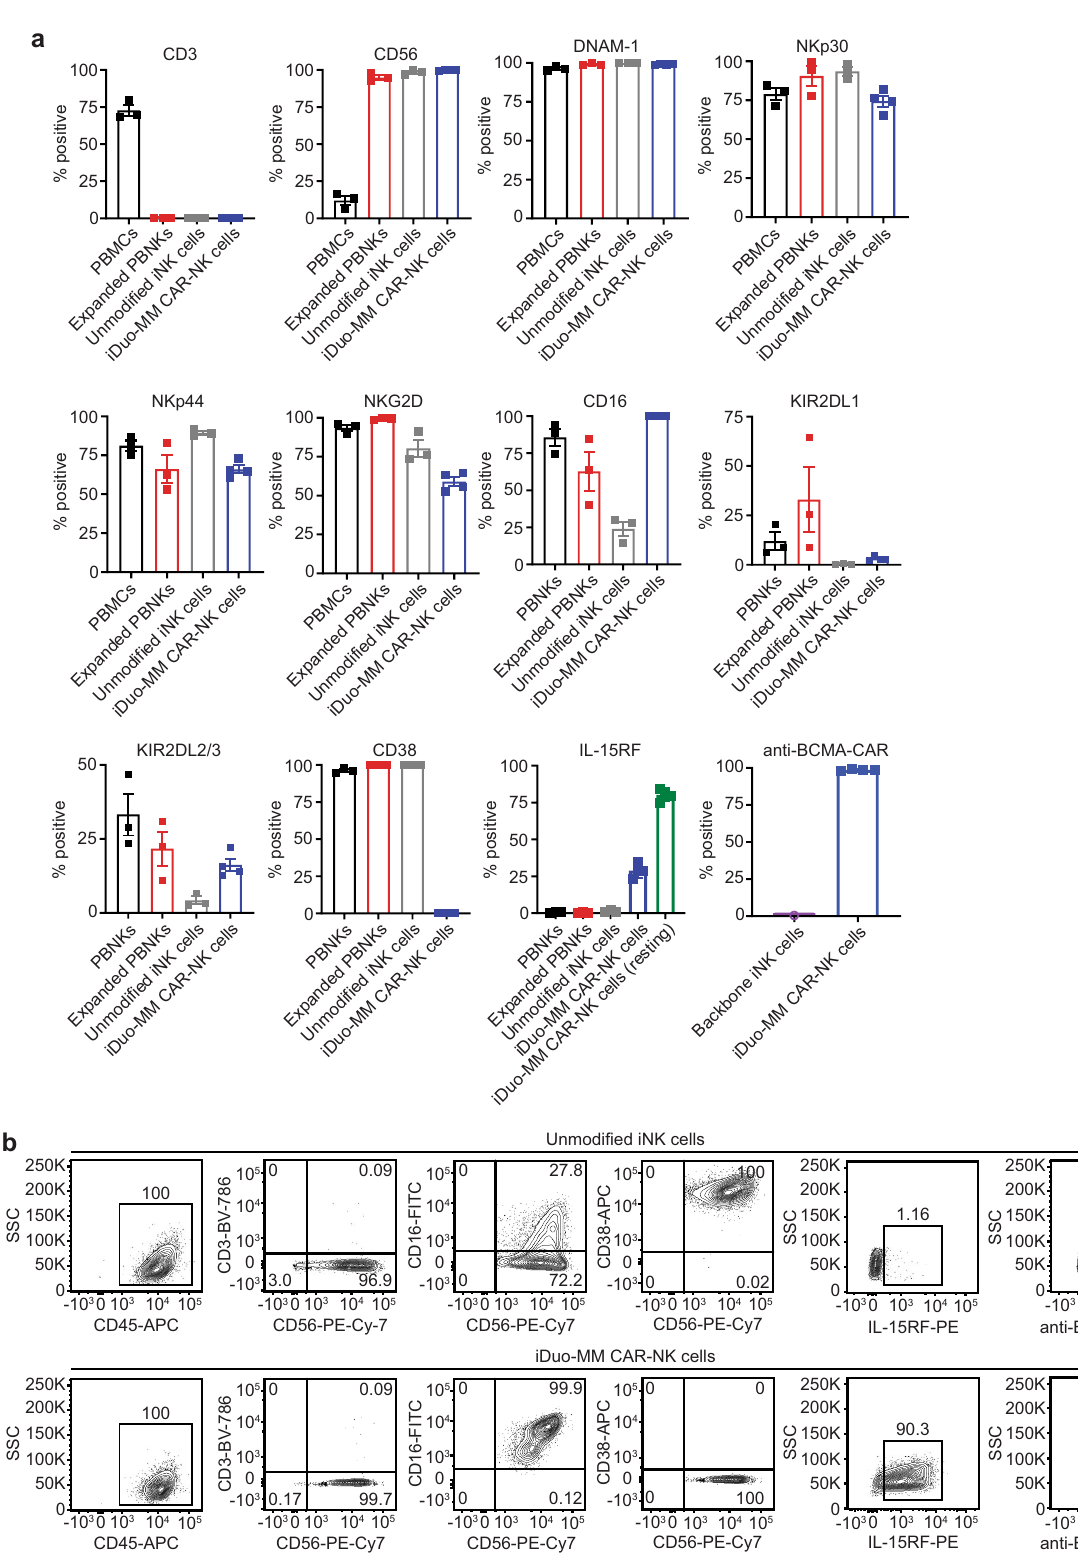
Fig. 1 | Phenotype of iDuo-MM CAR-NK cells. a Flow cytometry analysis of the indicated cell-surface proteins on PBMCs and PBNK cells from three healthy donors, unmodi fi ed iNK cells ( n =3 batches), and iDuo-MM CAR-NK cells ( n =4 batches). Backbone iNK cells ( n =3 batches) were also stained for comparison of